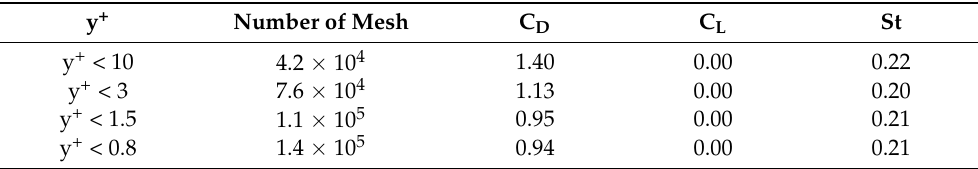
Table A1. Numerical results of a single cylinder with different numbers of mesh. y